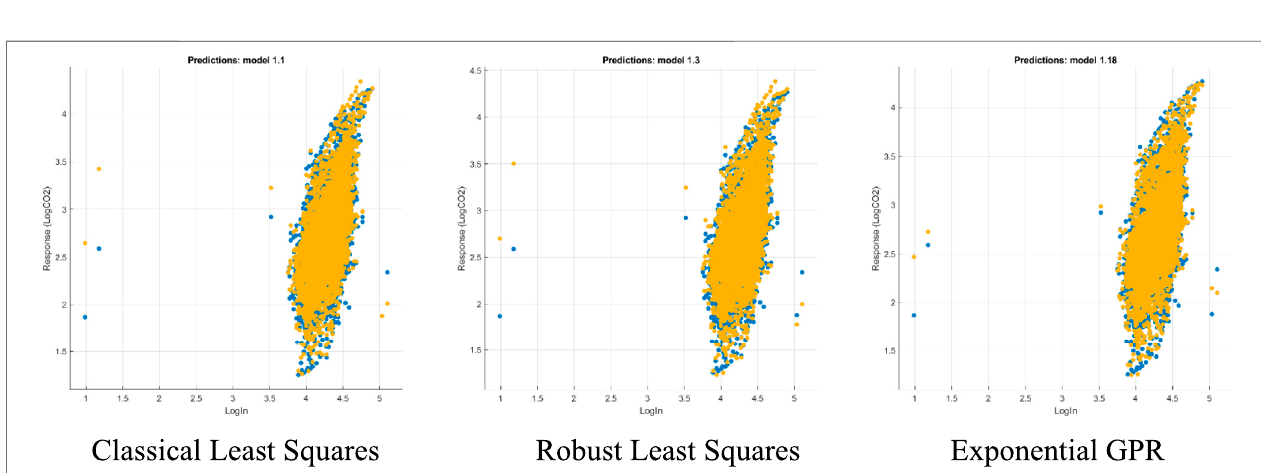
FIGURE7| Comparing actualand predictedCO 2 emissions against averageannual salaryofthe selectedmodels. Classical Least Squares RobustLeastSquares